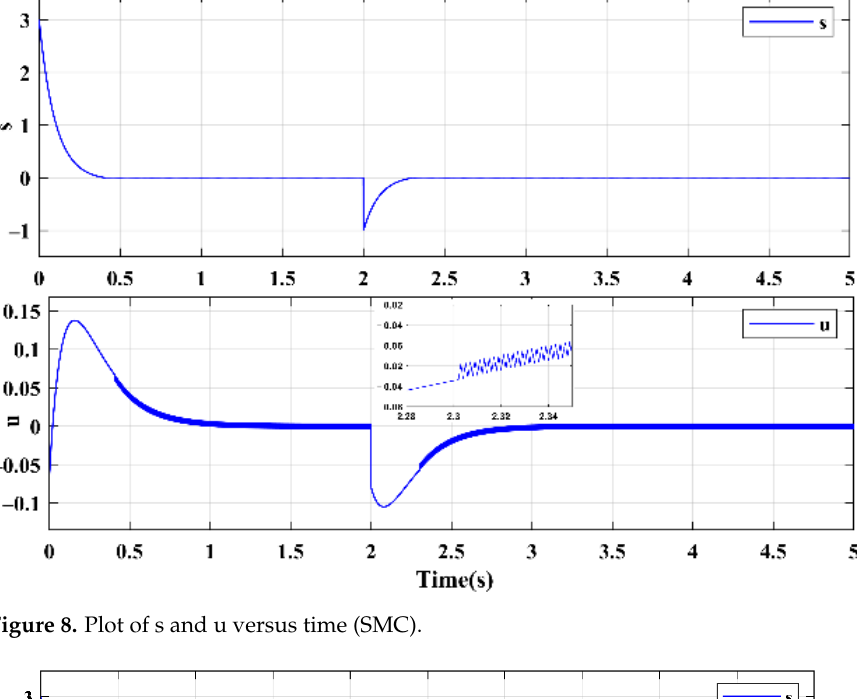
Figure 8. Plot of s and u versus time (SMC).